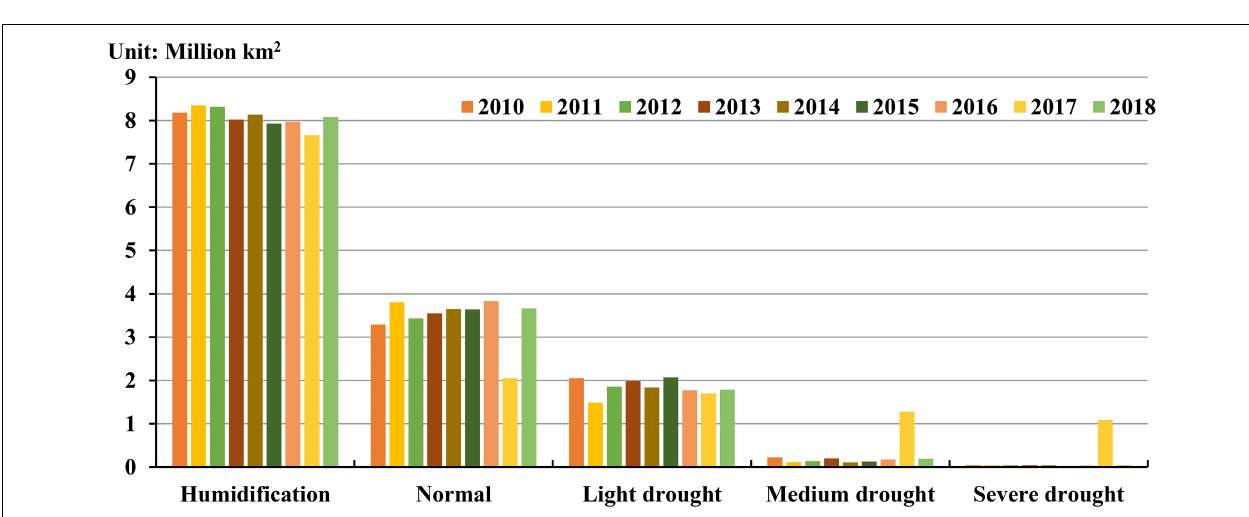
2018. The area of the medium drought areas increased year by year, and the area in the severe drought areas shows a decreasing trend. It is noteworthy that in 2011, 2015, and 2017, there